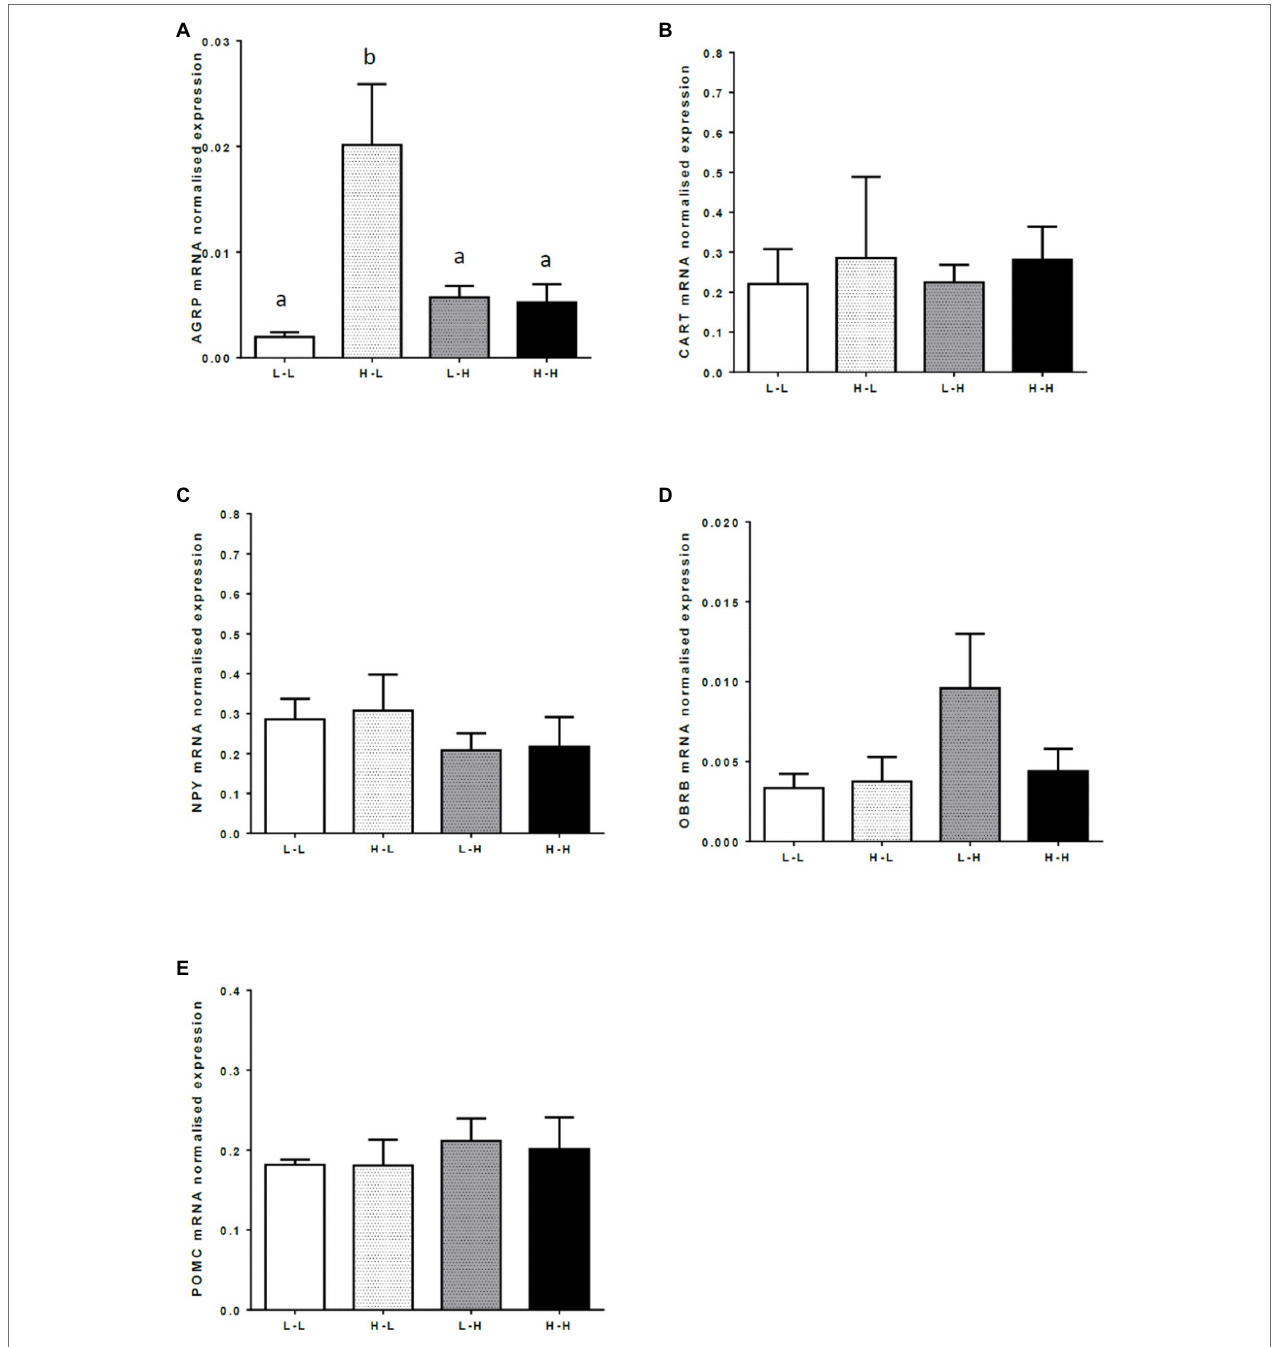
FIGURE 3 | Mean normalized hypothalamic mRNA expression of (A) Agouti-Related Protein ( ARGP ); (B) Cocaine and Amphetamine-Regulated Transcript ( CART ); (C) Neuropeptide Y ( NPY ); (D) Leptin receptor ( OBRB ); and (E) Proopiomelanocortin ( POMC ) in the arcuate nucleus from 20-month old bulls exposed to maternal diets low (L) and/or high (H) in protein during the peri-conception (PERI; − 60–23 dpc) or first trimester (POST; 24–98 dpc) periods of gestation 1 . (A) a,b Means without a common letter differ ( p < 0.05). (B–E) No significant differences between maternal diet groups ( p > 0.05). 1 LL, Low protein maternal diet during both PERI and POST diet periods. LH, Low protein maternal diet during PERI and High protein during POST diet periods. HL, High protein maternal diet during PERI and Low protein during POST diet periods. HH, High protein maternal during both PERI and POST diet